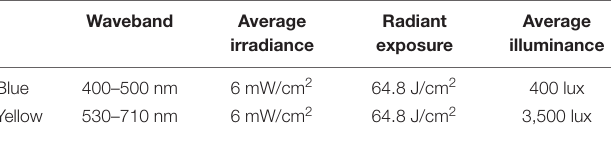
TABLE 1 | Spectral and intensity characteristics of customized light